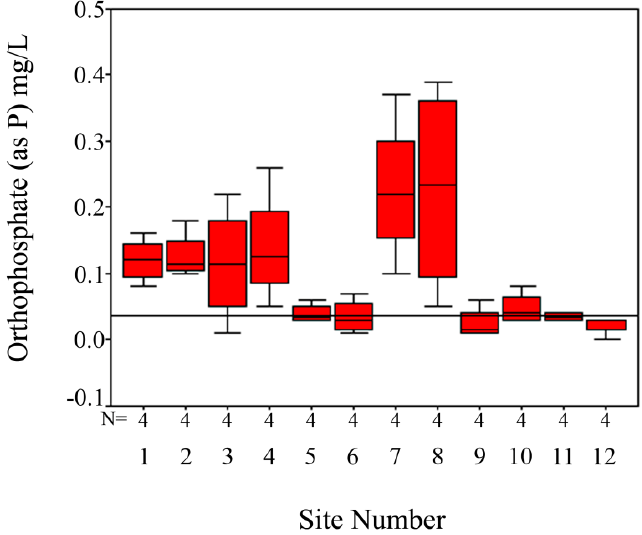
Figure 4. Box plot of orthophosphate (OP) concentrations in mg/L by site (4 samples/site) in the Little Choctawhatchee River watershed from October 2007 to June 2008.